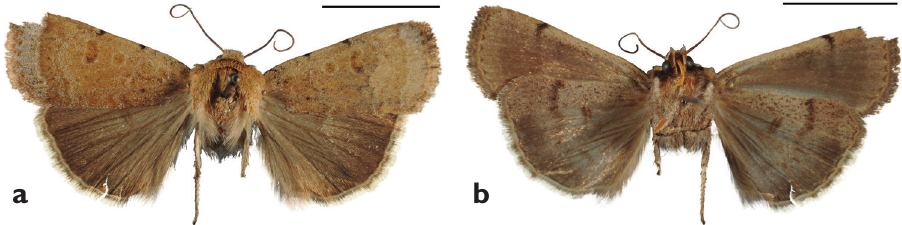
Figure 13. Lectotype of Rhynchagrotis nefascia Smith. a Dorsal b Ventral. Scale bars: 1 cm (Photos C. Richenbacher).